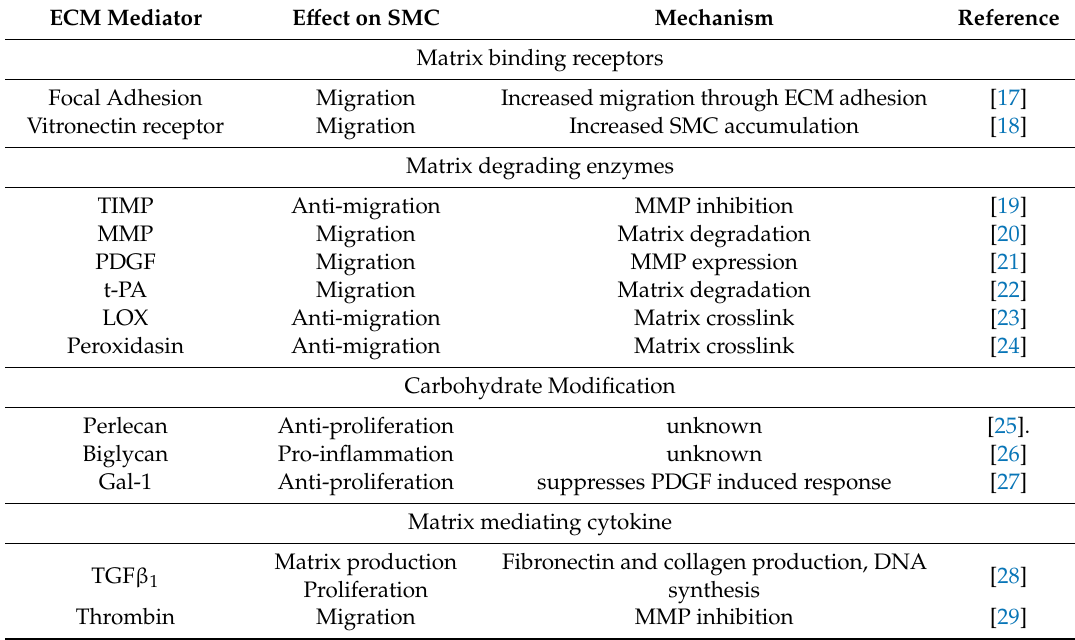
Table 2. Role of ECM-related mediators in systemic vascular intimal thickening.